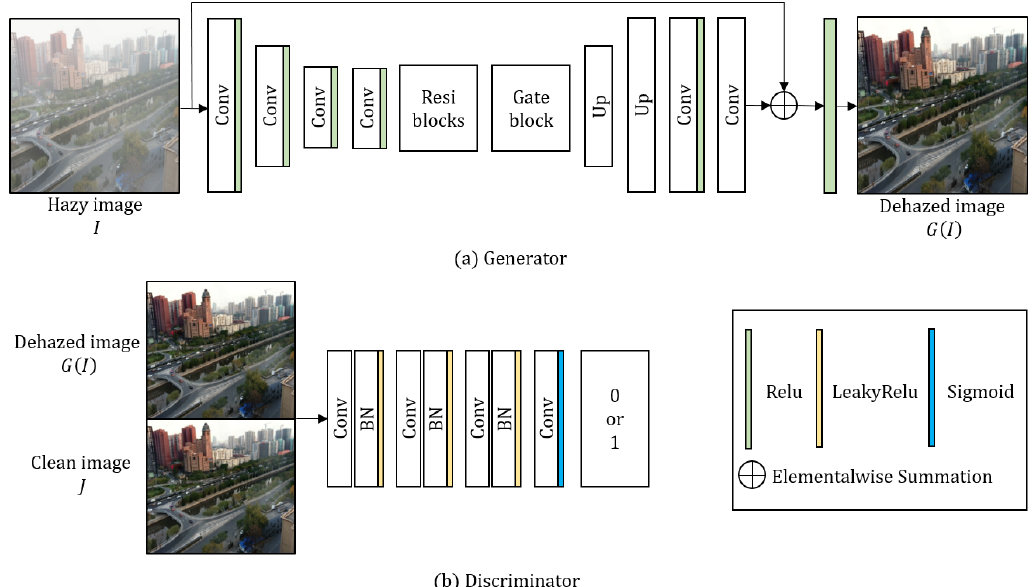
Figure 3. Overall architecture of the proposed